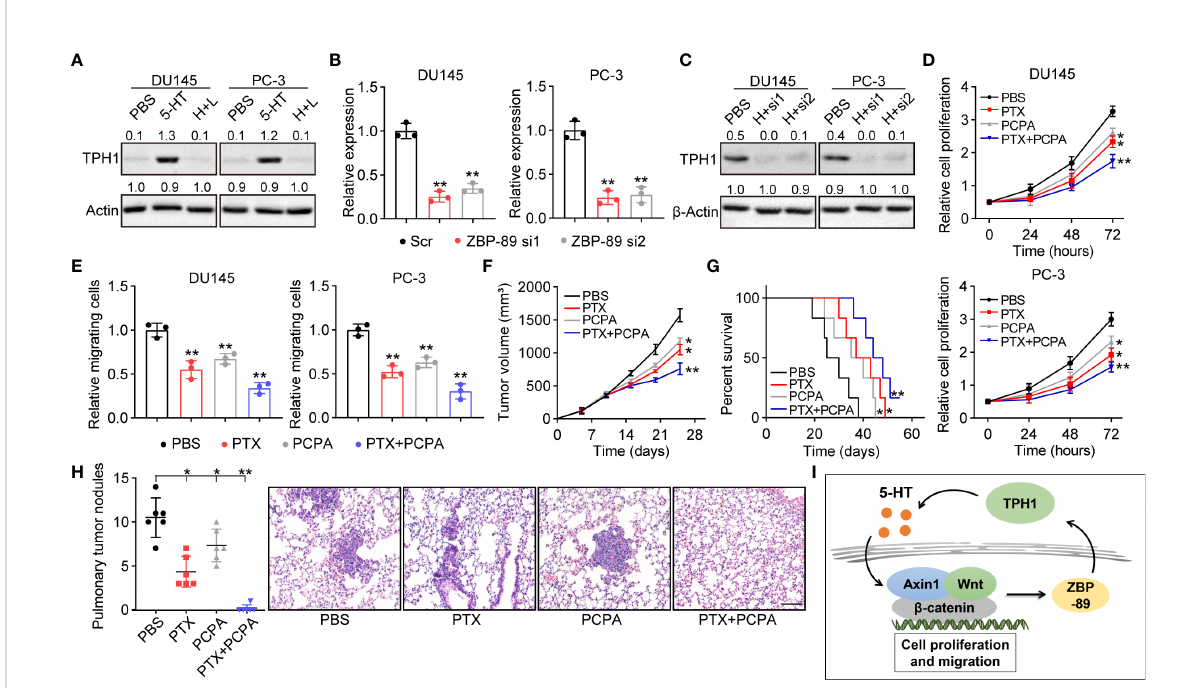
FIGURE 4 b -Catenin cooperates with zinc fi nger binding protein (ZBP)-89 to promote TPH1 and forms a signaling feedback loop. (A) Western blotting of TPH1 in DU145/PC-3 cells treated with PBS, 5-HT (5 m M), and 5-HT (5 m M) combined with LF3 (2 m M). (B) Relative expression of ZBP-89 in DU145/PC-3 cells treated with Scr and ZBP-89 siRNA, as determined by quantitative polymerase chain reaction (qPCR). (C) Western blotting of TPH1 in DU145/ PC-3 cells treated with 5-HT (5 m M) and 5-HT (5 m M) combined with ZBP-89 siRNA. (D) Proliferation of TPH1-overexpressing DU145/PC-3 cells treated with PBS, paclitaxel (PTX) (0.5 m g/ml), 4-chloro- DL -phenylalanine (PCPA) (2 m M), and a combination of the same. (E) Relative number of migrating TPH1-overexpressing DU145/PC-3 cells treated with PBS, PTX (0.5 m g/ml), PCPA (2 m M), and a combination of the same. (F) Tumor volume of TPH1-overexpressing PC-3 – bearing mice treated with PBS, PTX, PCPA, and a combination of the same. (G) Overall survival of TPH1- overexpressing PC-3 – bearing mice treated with PBS, PTX, PCPA, and a combination of the same. (H) M nodule numbers and hematoxylin and eosin (H&E) staining of lung tissues from TPH1-overexpressing PC-3 – bearing mice treated with PBS, PTX, PCPA, and a combination of the same. The scale bar is 100 m m. (I) Schematic diagram of the 5-HT/ b -catenin/ZBP-89/TPH1 signaling loop in prostate cancer. *p < 0.05; **p <